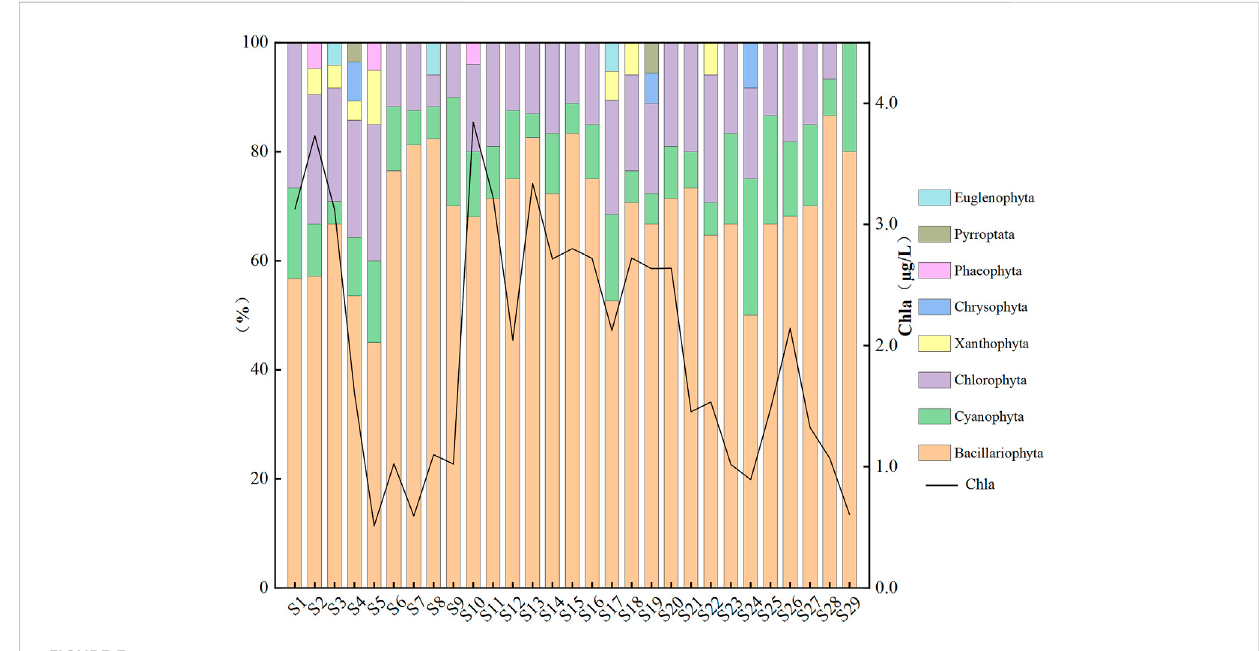
FIGURE 3 Proportion of phytoplankton phylum levels and Chla at sampling points.